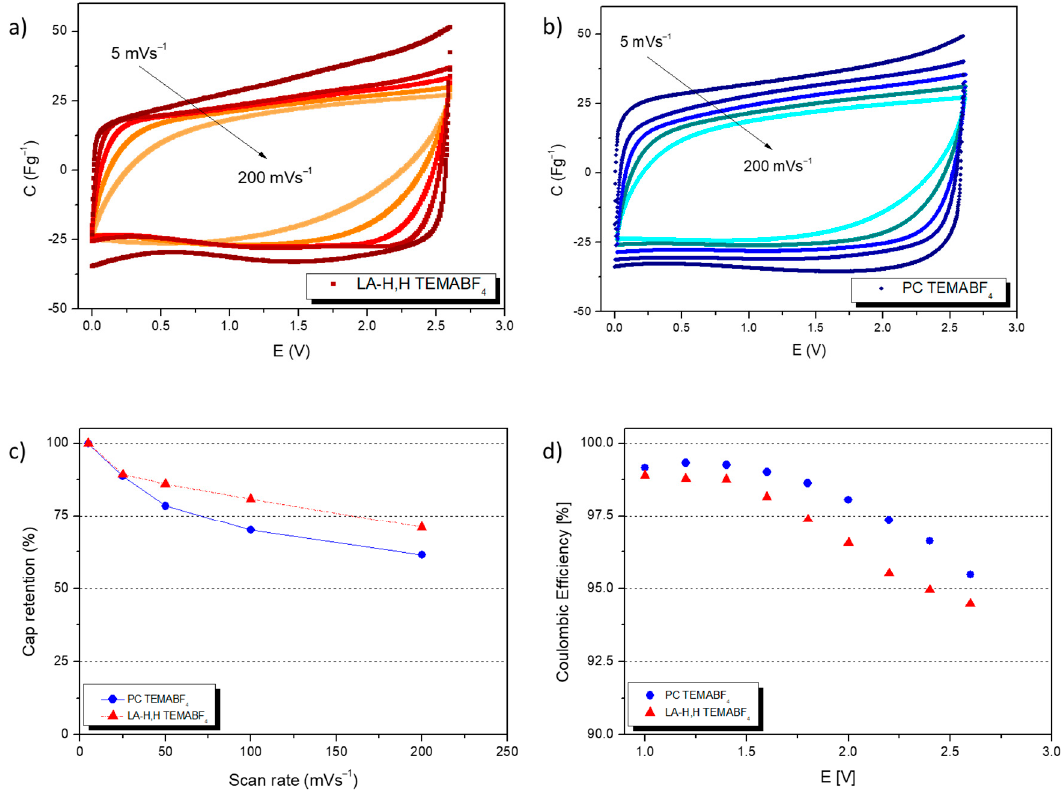
Figure 3. Cyclic voltammetry of LA-H,H and PC based electrolytes EDLC. ( a ) CV of LA-H,H TEMABF 4 1M at different scan rate: 5, 25, 50, 100, 200 mVs − 1 . ( b ) CV of PC TEMABF 4 1M at different scan rate: 5, 25, 50, 100, 200 mVs − 1 . ( c ) Capacitance retention at different scan rate of EDLCs containing investigated electrolytes. ( d ) Coulombic efficiency at different cell voltage of EDLCs containing investigated electrolytes.